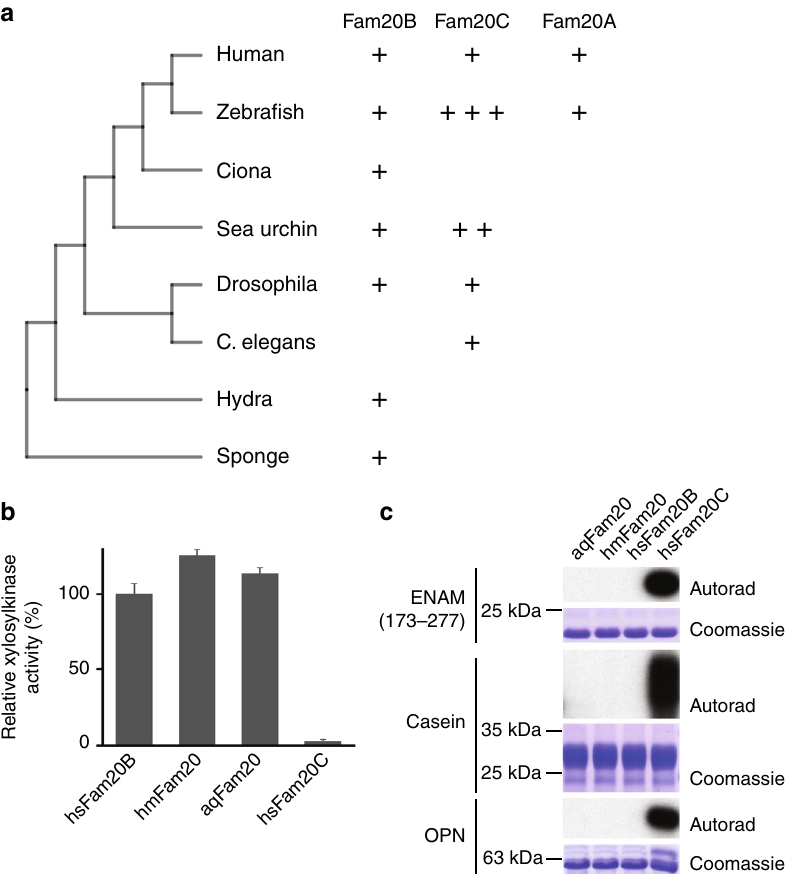
Fig. 5 Phylogenetic analyses of the Fam20 proteins. a A diagram depicting the presence of different Fam20 proteins in representative species. b The Fam20 proteins from sponge (aqFam20) and hydra (hmFam20) phosphorylate the Gal-Xyl disaccharide with ef fi ciencies similar to human Fam20B (hsFam20B). Error bars represent the standard deviation of three independent experiments. c Only human Fam20C phosphorylates enamelin, casein, and OPN, as revealed by 32 P (Fig. 6b). Thr114 forms a hydrogen bond with the C3 hydroxyl because it contains a Gln instead of an acidic Asp/Glu at this group of the Xyl. Gln115 forms hydrogen bonds with both the C3 position 20,21 . The Gal-Xyl is accommodated next to the ATP- binding site, in a pocket formed by Thr114, Gln115, Tyr148, hydroxyl group of the Xyl and the C5 hemiacetal oxygen in the Glu149, Gly150, Tyr151, Tyr214, Tyr253, His301, and Lys321 Gal. Gly150 uses the main chain amine and carbonyl groups to